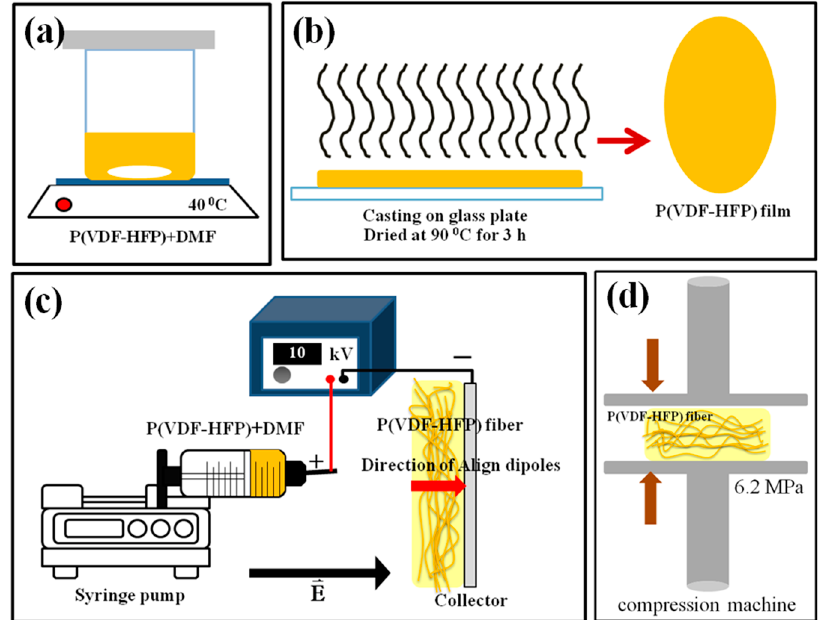
Figure 1. Schematic of the synthesis used with all samples. ( a ) Homogeneous poly(vinylidene fluoride-hexafluoropropylene) (P(VDF-HFP) solution, ( b ) solution casting, ( c ) electrospinning, and ( d ) fibrous film compression .